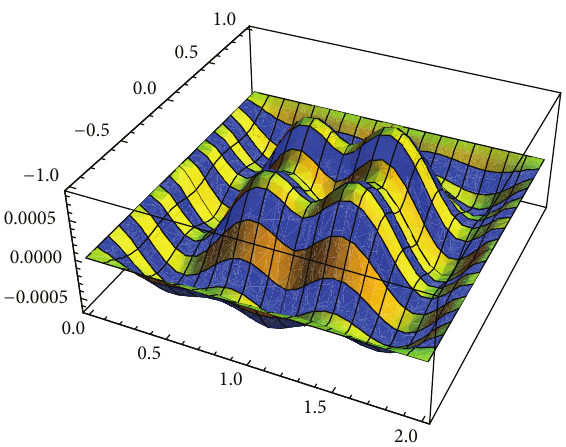
Figure 4: The error surface of the EH (𝑥,𝑦) − 𝑓(𝑥,𝑦) .